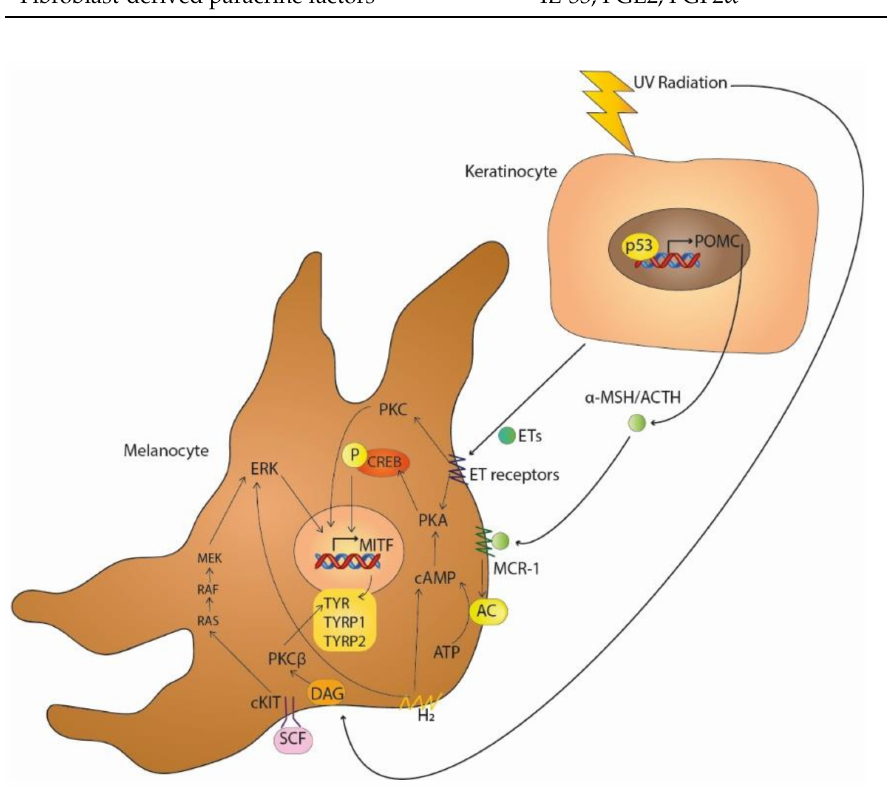
Figure 1. UV-induced melanogenesis by the secretion of α -MSH/ACTH and ETs by keratinocytes activating MCR-1 and G protein-coupled ETs receptors, respectively, and by the induction of DAG on melanocytes membranes. Paracrine pathways, such as SCF-c-KIT receptor tyrosine kinase and H 2 receptors, also induce